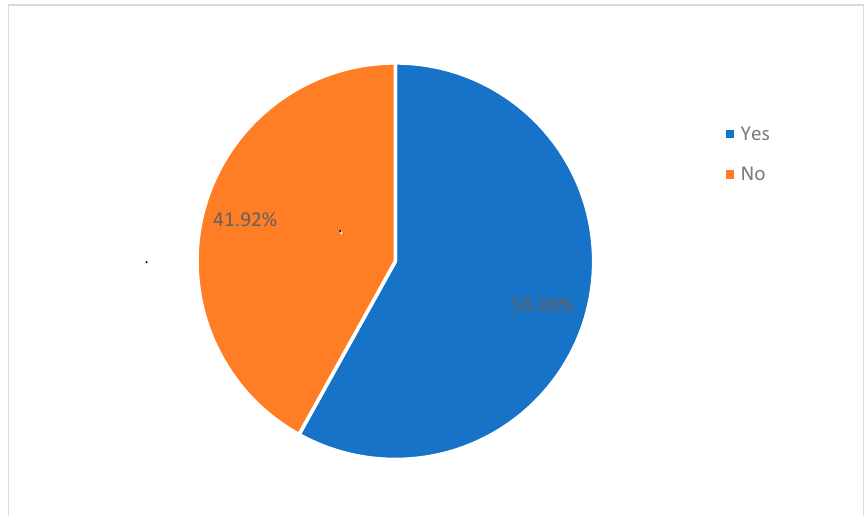
Figure 4. Responses to the question, “Do you know that one third of totally produced food is re- jected?”